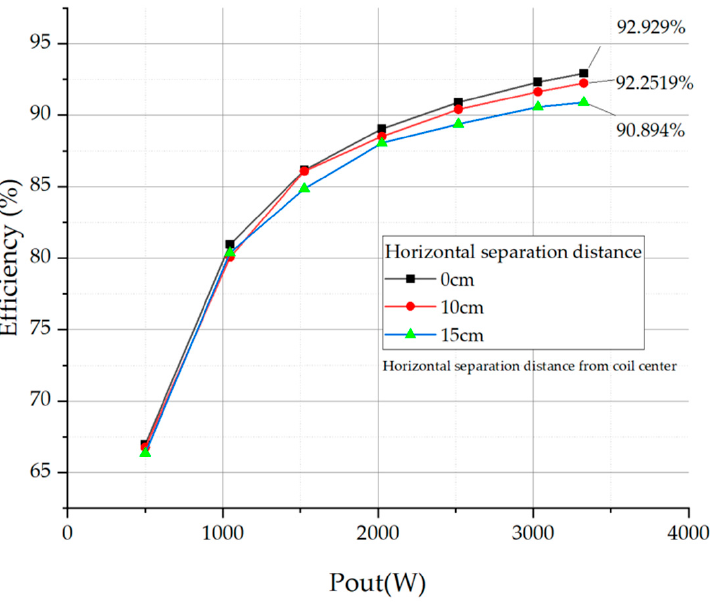
Figure 19. Efficiency with respect to the coil separation distance. Figure 19. E ffi ciency with respect to the coil separation distance.